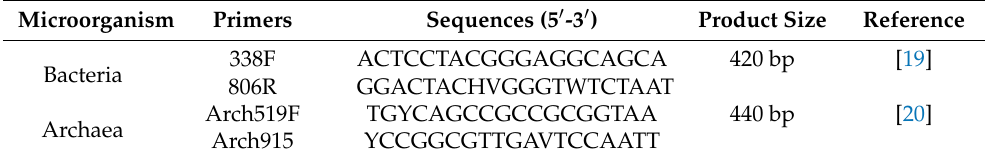
Table 1. The primers for